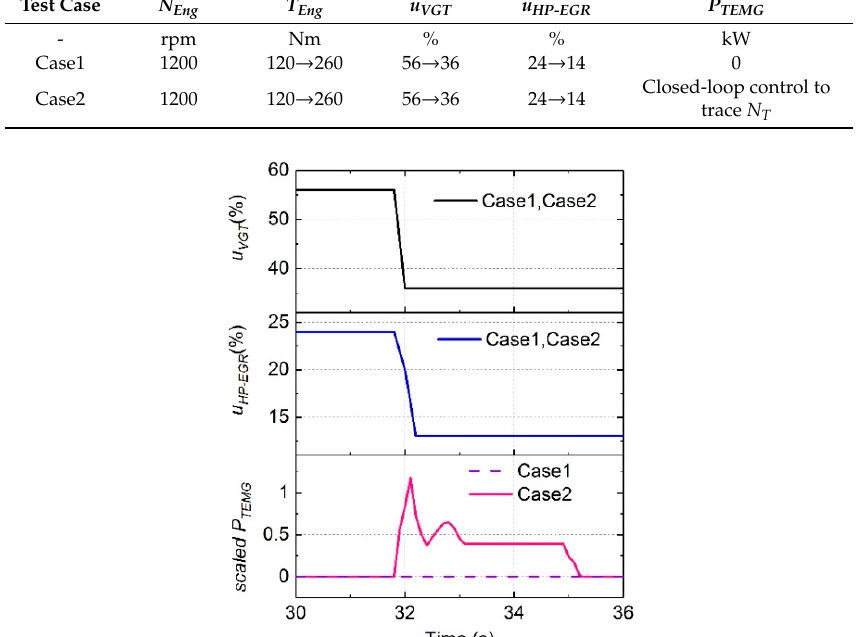
Figure 10. Tip-in test for the nominal system without assist.